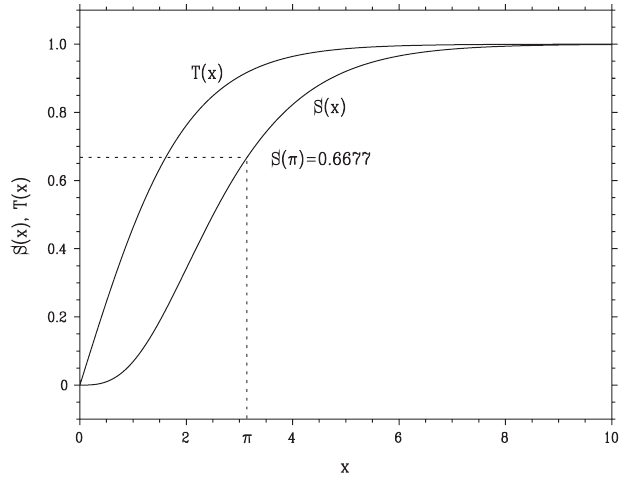
FIG. 5. Functions S ð x Þ and T ð x Þ in Eq.